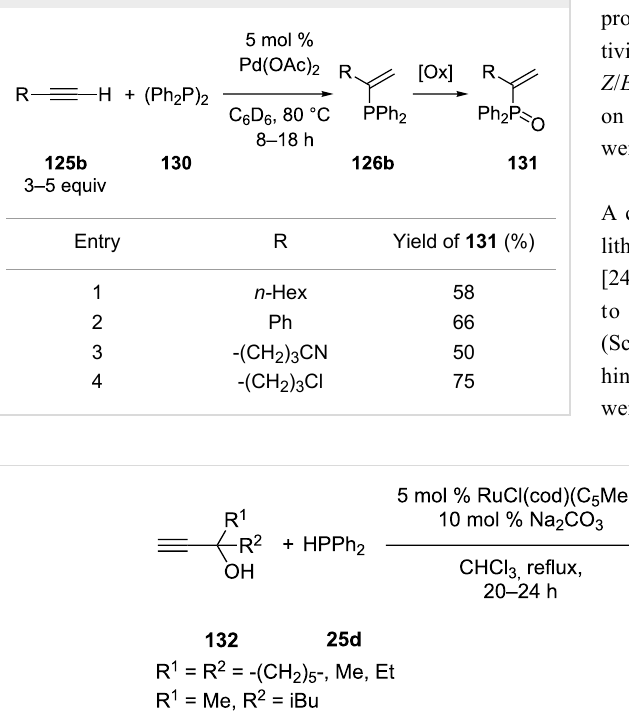
Table 14: Pd-catalyzed hydrophosphination of alkynes 125b using diphosphine 130